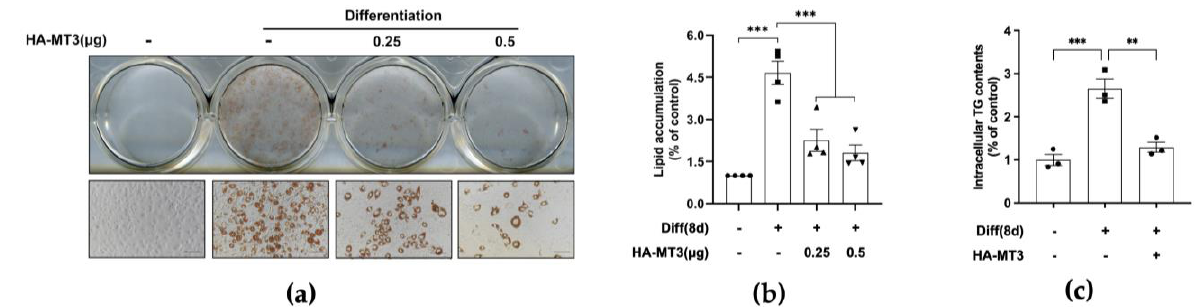
Figure 3. Mt3 overexpression inhibits lipid accumulation in 3T3 − L1 adipocytes. 3T3 − L1 cells were transfected with HA − MT3 plasmid (0.25, 0.5 µ g) prior to contact inhibition and incubated with differentiation cocktail to induce adipocyte differentiation. Oil Red O staining was used to measure the extent of lipid accumulation on day 8. ( a ) Representative images of 3T3-L1 adipocytes were captured at 200 × magnification. Scale bar = 100 µ m. ( b ) The lipid accumulation in 3T3 − L1 adipocytes was quantified as a percentage of control values. ( c ) Intracellular triglyceride content was measured by using a commercial kit. The data are presented as the means ± SEM. ** p < 0.01, *** p < 0.001 vs. followed by Tukey’s